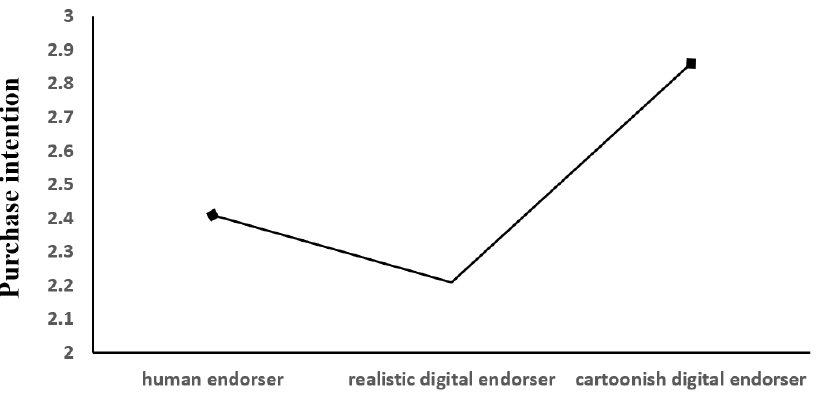
Figure 3. The main effect of endorser type on purchase intention.